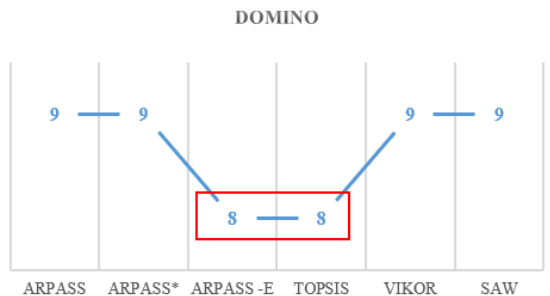
Figure 18. Rank fluctuation of Domino in the investigated MCDM methods.